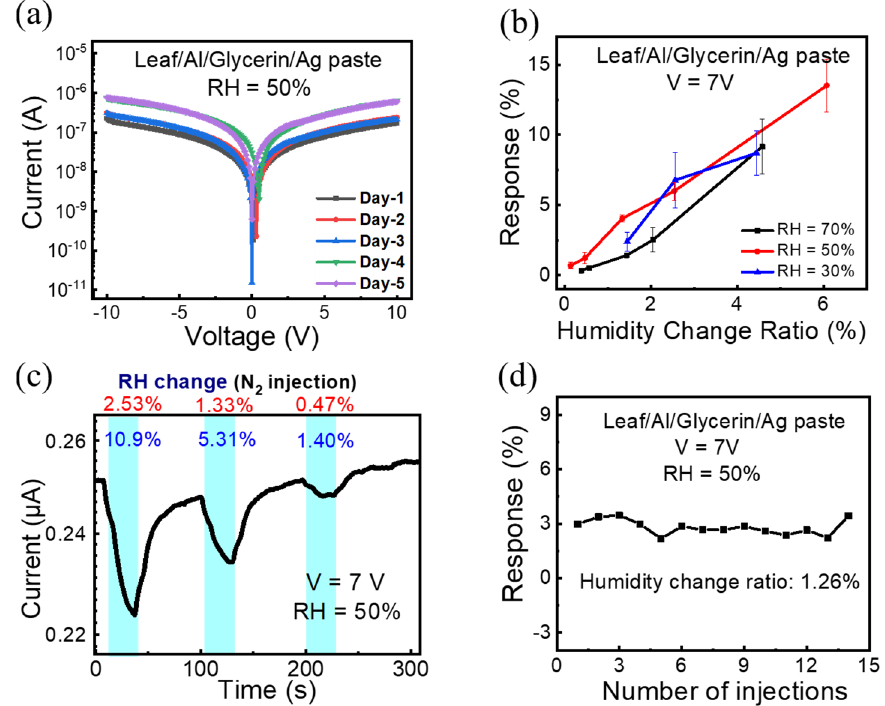
Figure 4. ( a ) I-V curve of the sensor measured at different days. ( b ) Calibration analysis between response and humidity change ratio. ( c ) The real-time humidity sensing curve under background RH = 50%. ( d ) The response of every test with 1.26% humidity changed.